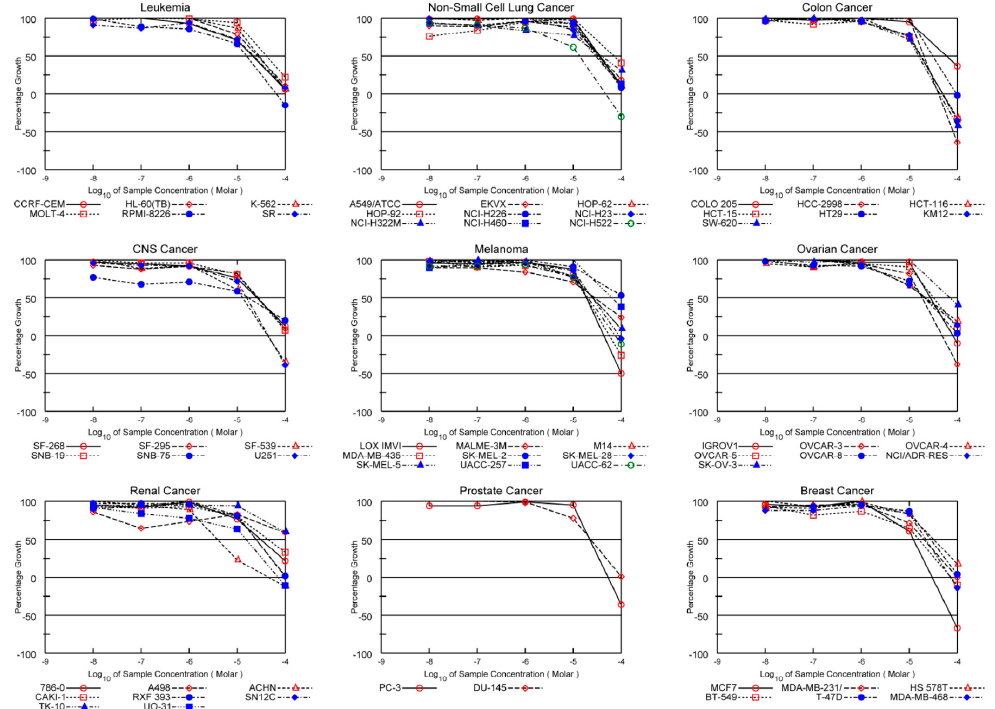
Figure 6. The anti-tumor effect of platyphylloside ( 2 ) in the NCI-60 cancer cell lines in a 5-dose dependent manner. The cytotoxic effect of platyphylloside ( 2 ) in the NCI-60 tumor cell panel shows a preference for renal cancer cell lines.